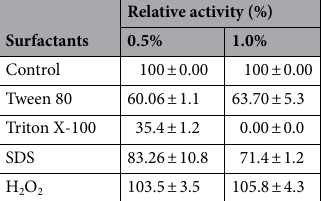
Table 3. Effect of different surfactants and oxidizing agent on the activity of purified cold-active Apr-BO1.